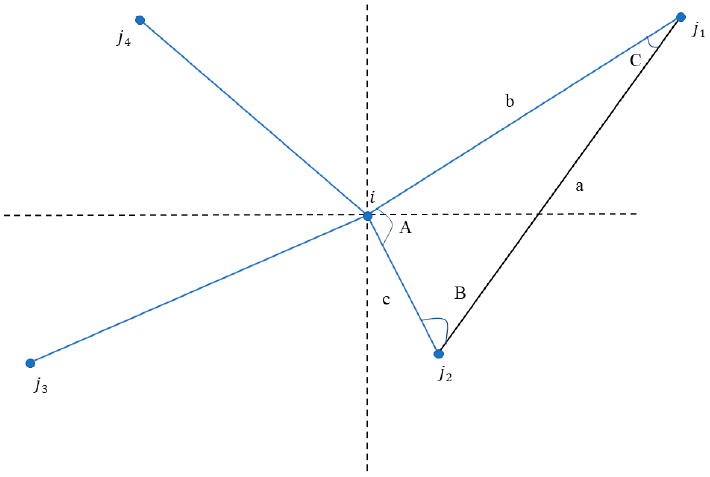
Figure 2. Calculating angle of A made by links 𝑖𝑗 (cid:2869) and 𝑖𝑗 (cid:2870) at node 𝑖 using the Cosine